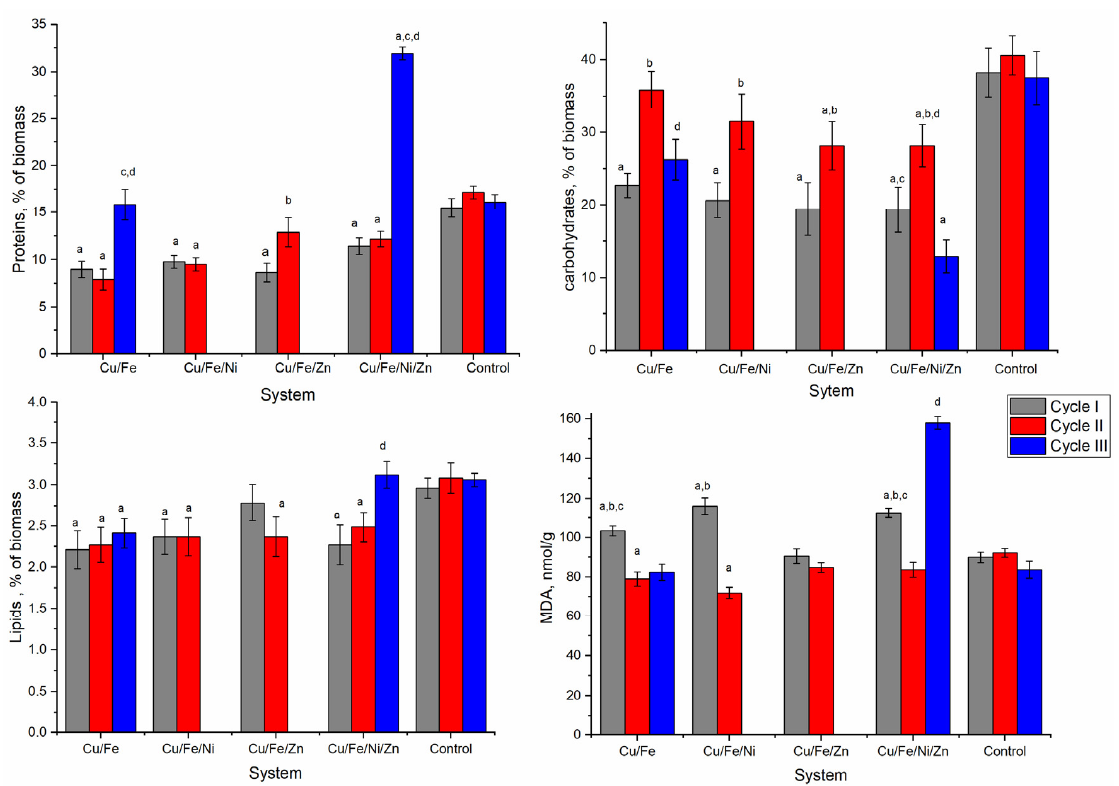
Figure 4. Total proteins; carbohydrates; lipids and malondialdehyde in Nostoc linckia biomass obtained over three cycles of cultivation in multimetallic systems (a— p < 0.001 for the difference between experimental and control samples, b— p < 0.001 for the difference between the first and second cycle, c— p < 0.001 for the difference between the first and third cycles, d— p < 0.001 for the difference between the second and third